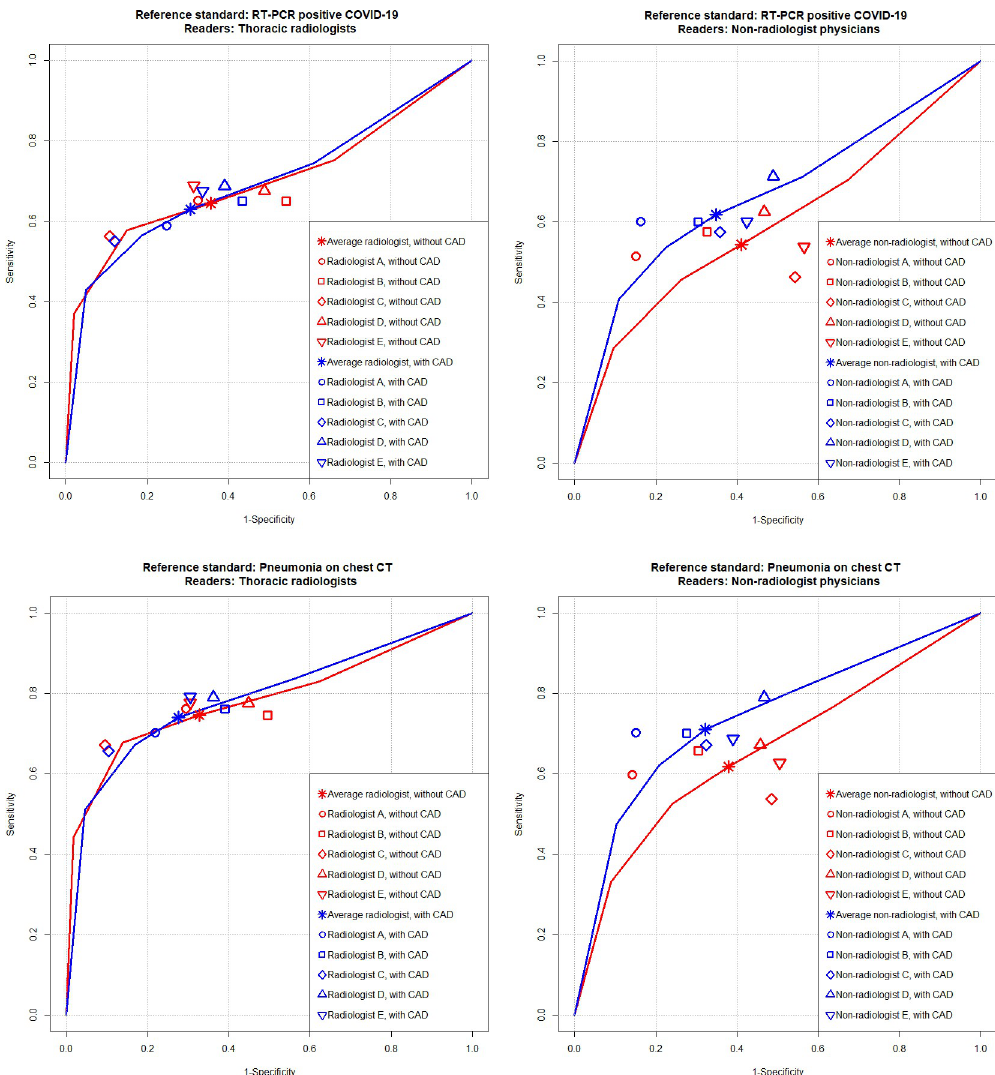
Fig 5. Performance of physician alone versus CAD-assisted interpretations. For identification of RT-PCR positive COVID-19 patients, the AUCs of thoracic radiologists did not significantly differ between reader-alone (red line) and CAD- assisted interpretations (blue line) (0.701 vs. 0.699; P = .815) ( A ), while the AUC non-radiologist physicians was significantly improved in the CAD-assisted interpretation (blue line) compared to the reader-alone interpretation (red line) (0.584 vs. 0.664; P = .006) ( B ). For identification of pneumonia defined on chest CT, the AUCs of thoracic radiologists also did not significantly differ between reader-alone (red line) and CAD-assisted interpretations (blue line) (0.784 vs. 0.789; P = .524) ( C ), while the AUC non-radiologist physicians was significantly improved in the CAD-assisted interpretation (blue line) compared to the reader-alone interpretation (red line) (0.650 vs. 0.738; P = .003) ( D ).